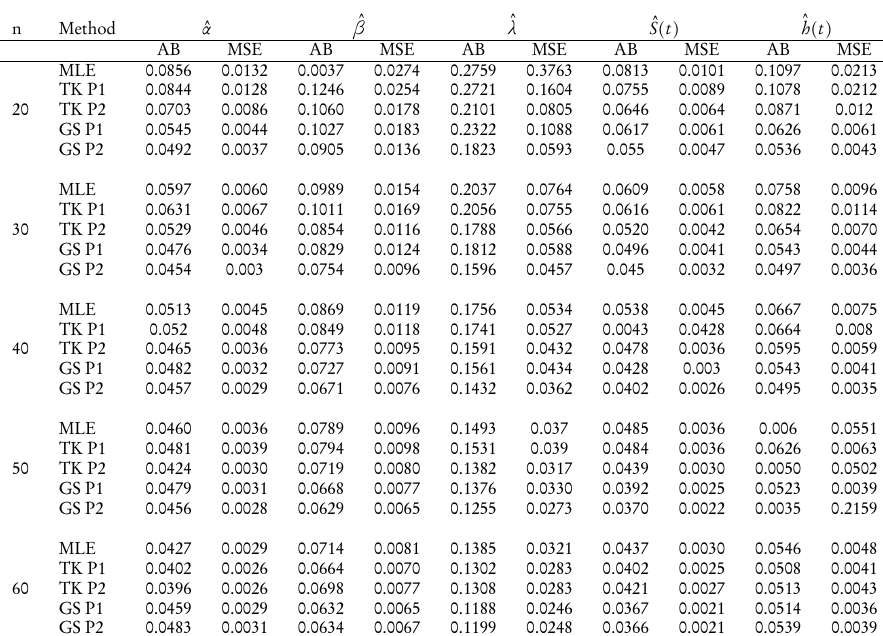
The ML and Bayes estimates of parameters and reliability characteristics when α = 0.5, β = 0.5, λ = 1,